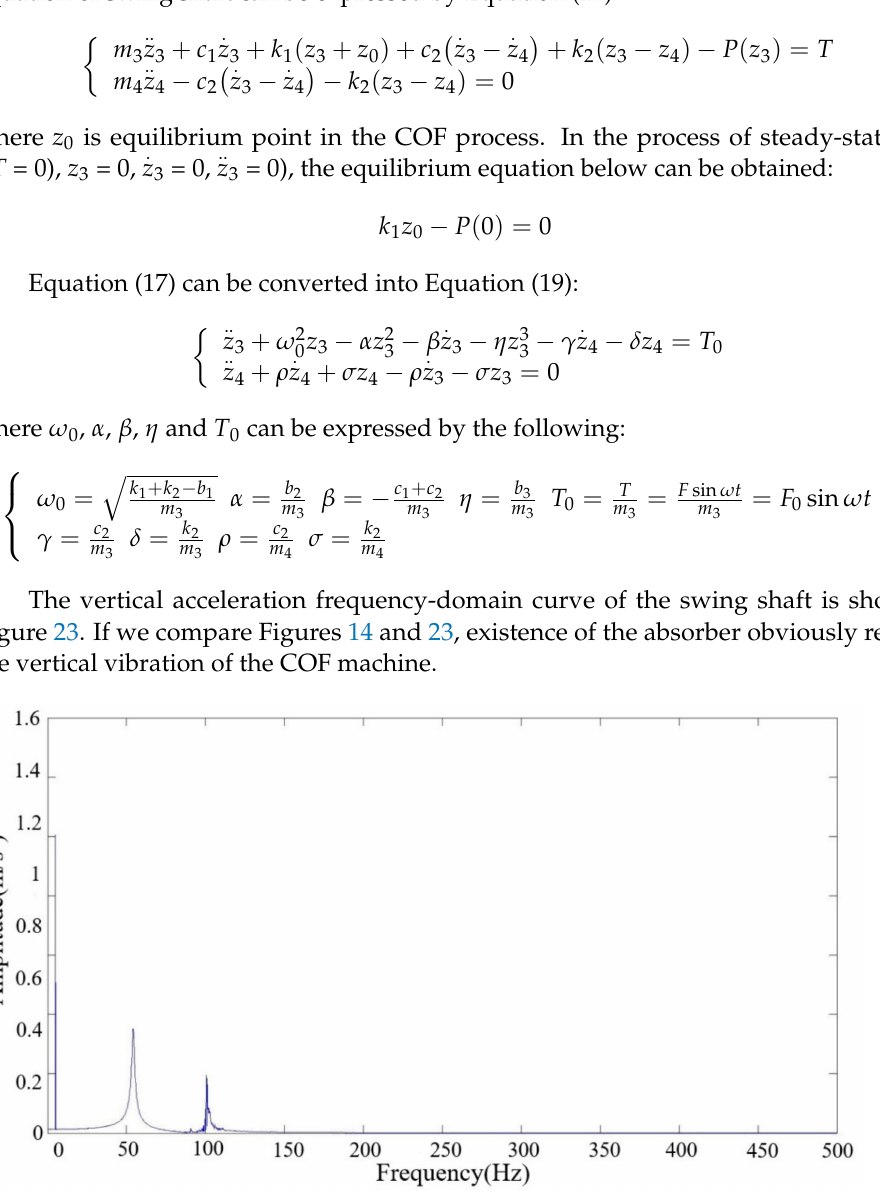
Figure 23. Vertical acceleration frequency-domain curve of the swing